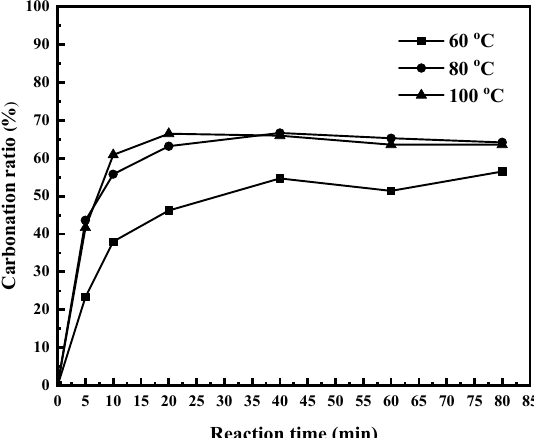
Figure 5. Effect of reaction temperature on carbonation of AOD slag.